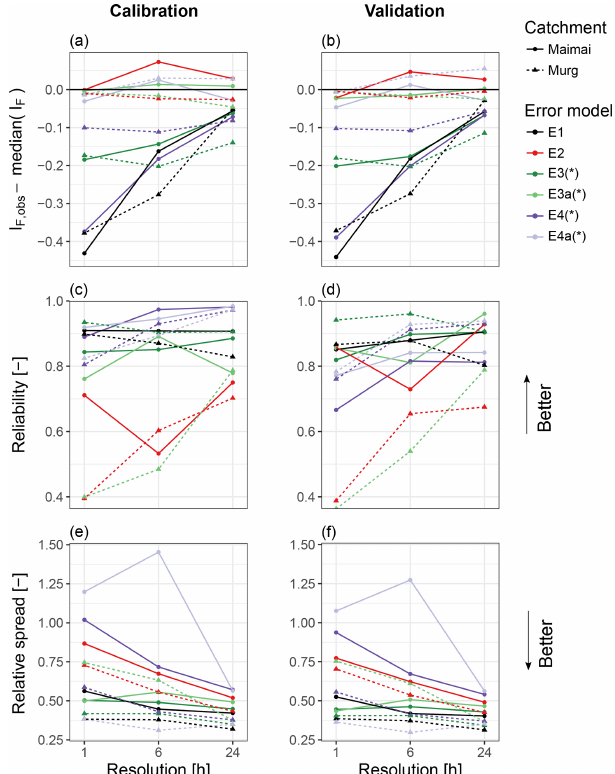
Figure 3. Performance of the error models with respect to the flashi- ness index, reliability and relative spread for both catchments and all temporal resolutions. P err was smoothed ( ∗ ) exclusively for hourly data in the Maimai